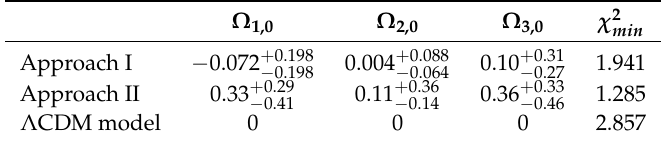
Table 2. The best fit values for Ω 1,0 , Ω 2,0 and Ω 3,0 . The upper and lower limits stand for 2 σ